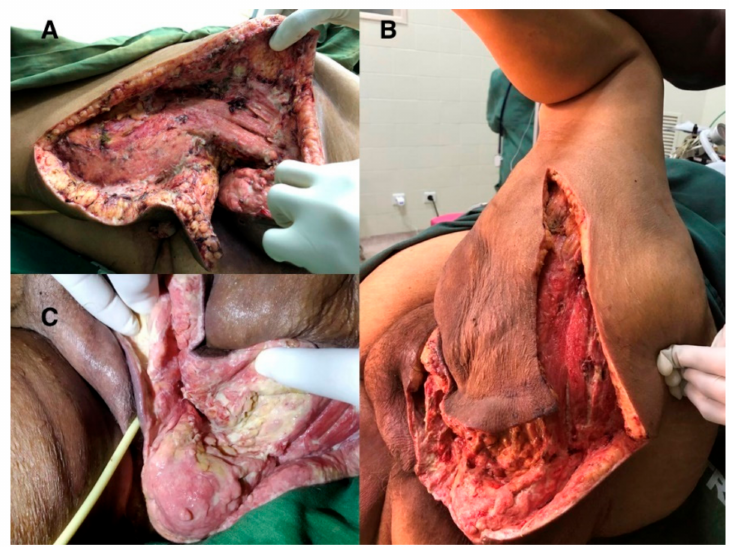
Figure 1. Clinical presentation of a massive Fournier’s gangrene after preliminary exploration ( A ), after 1 day of treatment ( B ) and after 6 days ( C ).